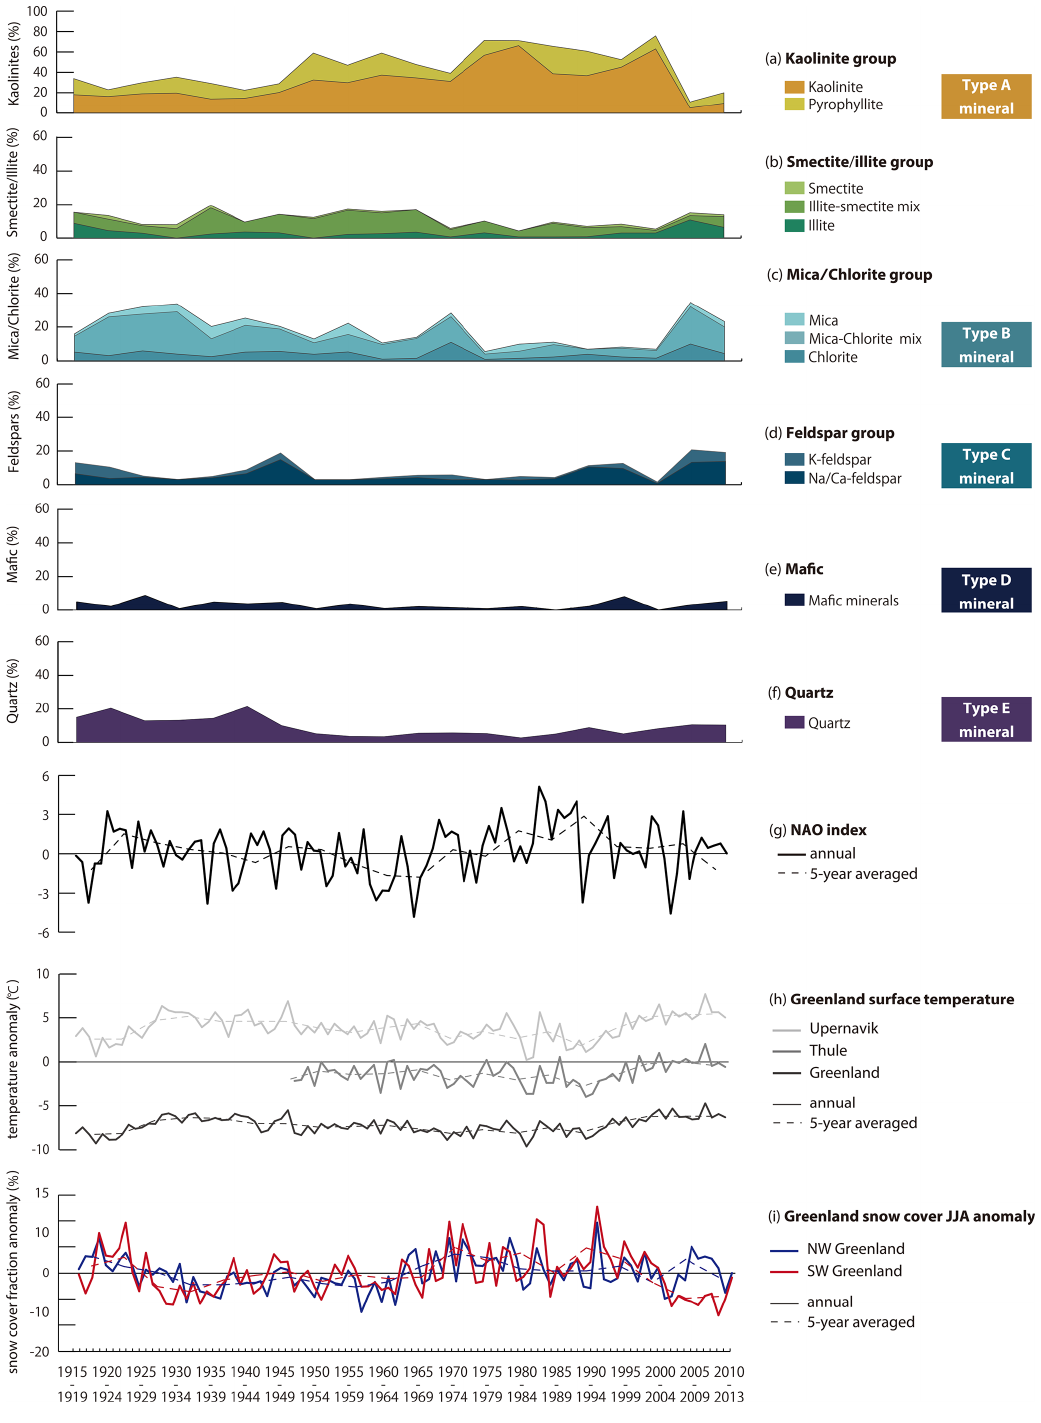
Figure 9. Comparison of historical changes in proportion of silicate minerals from the SIGMA-D ice core ( a : kaolinite group, b : smectite group, c : mica–chlorite group, d : feldspar group, e : mafic mineral, f : quartz) with those in (g) the North Atlantic Oscillation index (NAO; Hurrell and National Center for Atmospheric Research Staff, 2020) and (h) surface temperature anomalies and (i) snow cover fraction anomalies in Greenland. Surface temperature anomalies deviate from the 1948–2013 average in Thule. The temperature record of Greenland is from Berkeley Earth, and Thule (Pituffik) and Upernavik in western Greenland located 100km south and 650km southeast of Qaanaaq are from Cappelen (2019). Snow cover fraction anomalies deviate from the 1915–2013 average in NW and SW Greenland.